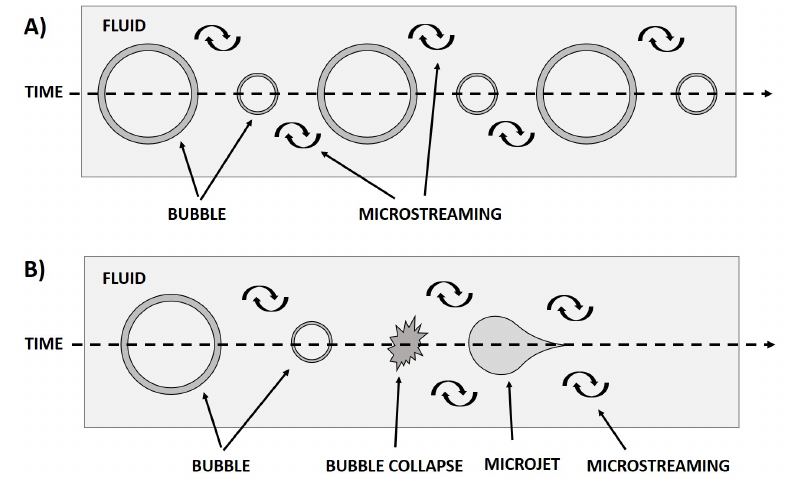
Figure 1. Schematic of ( A ) Stable Cavitation and ( B ) Inertial Cavitation. In this case, stable cavitation is the oscillation of a bubble or contrast agent, which causes fluid motion, or micostreaming. Inertial cavitation is the collapse of a bubble or contrast agent, resulting in both microstreaming and a stronger microjet of